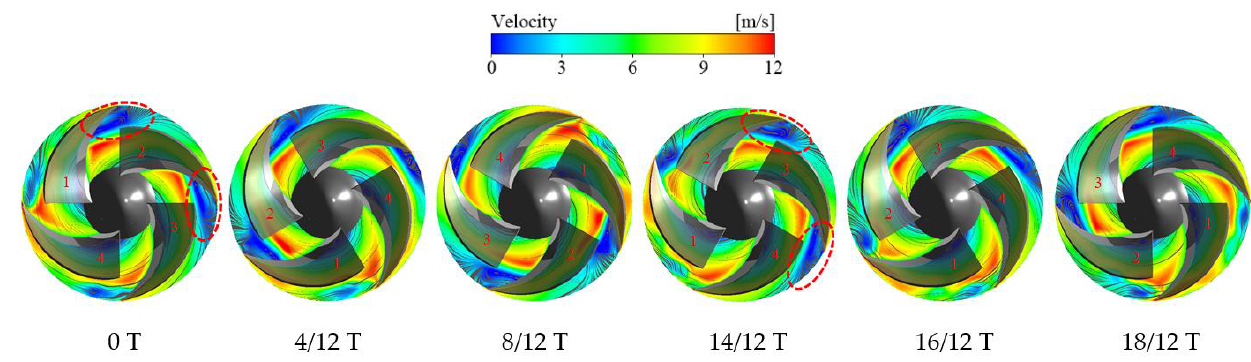
Figure 12. Velocity streamline diagram of impeller outlet section at different time ( δ = 0.5 mm).